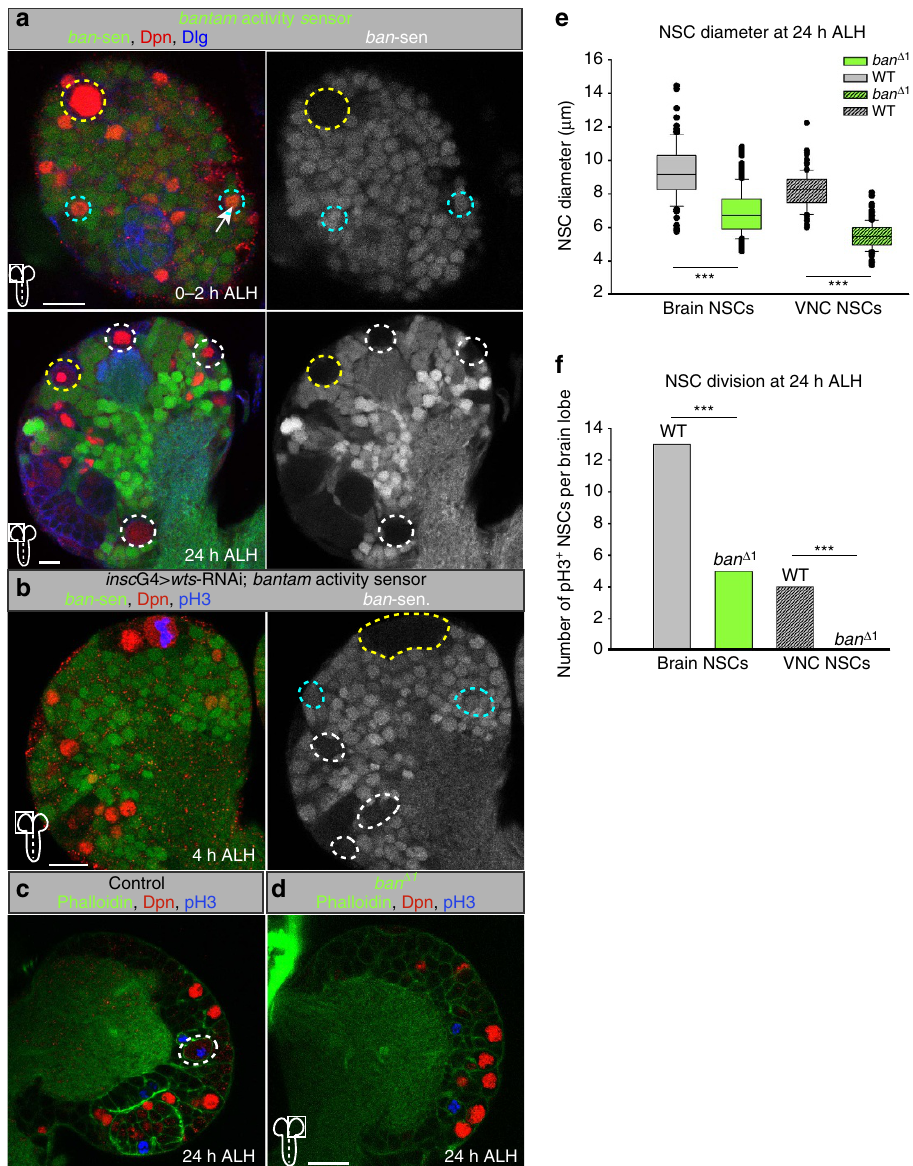
Figure 4 | The microRNA bantam is active during reactivation and necessary for NSC growth and proliferation. ( a ) bantam ( ban )-activity sensor in brain lobes at 0–2h (upper panels) and 24h (lower panels) ALH. No GFP signal monitors ban activity. Quiescent NSCs (cyan circles) do not have active bantam (GFP-positive), whereas reactivated NSCs (white circles) or the MBNB (yellow circles) have active ban . Right panels show GFP channel in monochrome. ( b ) NSC-specific wts -RNAi leads to premature ban activity (loss of GFP) at 4h ALH. ( c , d ) NSC growth and proliferation is decreased in ban D 1 mutants ( d ) compared with control ( c , white circles marks NSC in division) at 24h ALH. Phalloidin in green. ( e , f ) Quantification of NSC cell diameters ( e ) and proliferation ( f ) in ban D 1 mutants at 24h ALH. ( e ) *** P o 0.001. Wilcoxon rank sum test. Median and s.d. were calculated from two biological replicates. Control brain n ¼ 109 NSCs (3 brain lobes); ban D 1 brain n ¼ 319 NSCs (7 brain lobes); control VNC n ¼ 109 NSCs (3 VNC); ban D 1 VNC n ¼ 253 NSCs (4 VNC). ( f ) Average number of NSCs in mitosis (pH3-positive) at 24h ALH in wild-type of 3 brain lobes and 3 VNCs and ban D 1 7 brain lobes and 4 VNCs. All images are single focal planes, anterior up. Scale bar, 10 m m. See also Supplementary Fig.